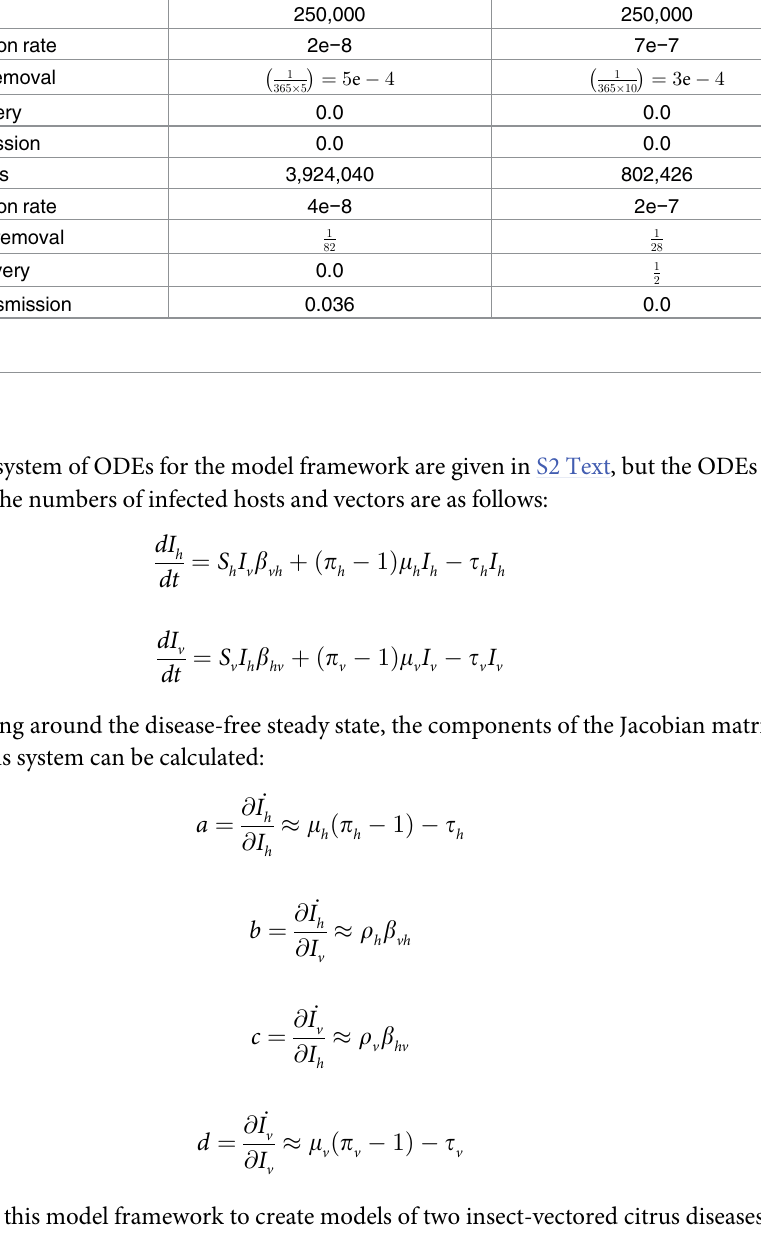
economic importance to the global citrus industry: huanglongbing (HLB) and tristeza diseases.